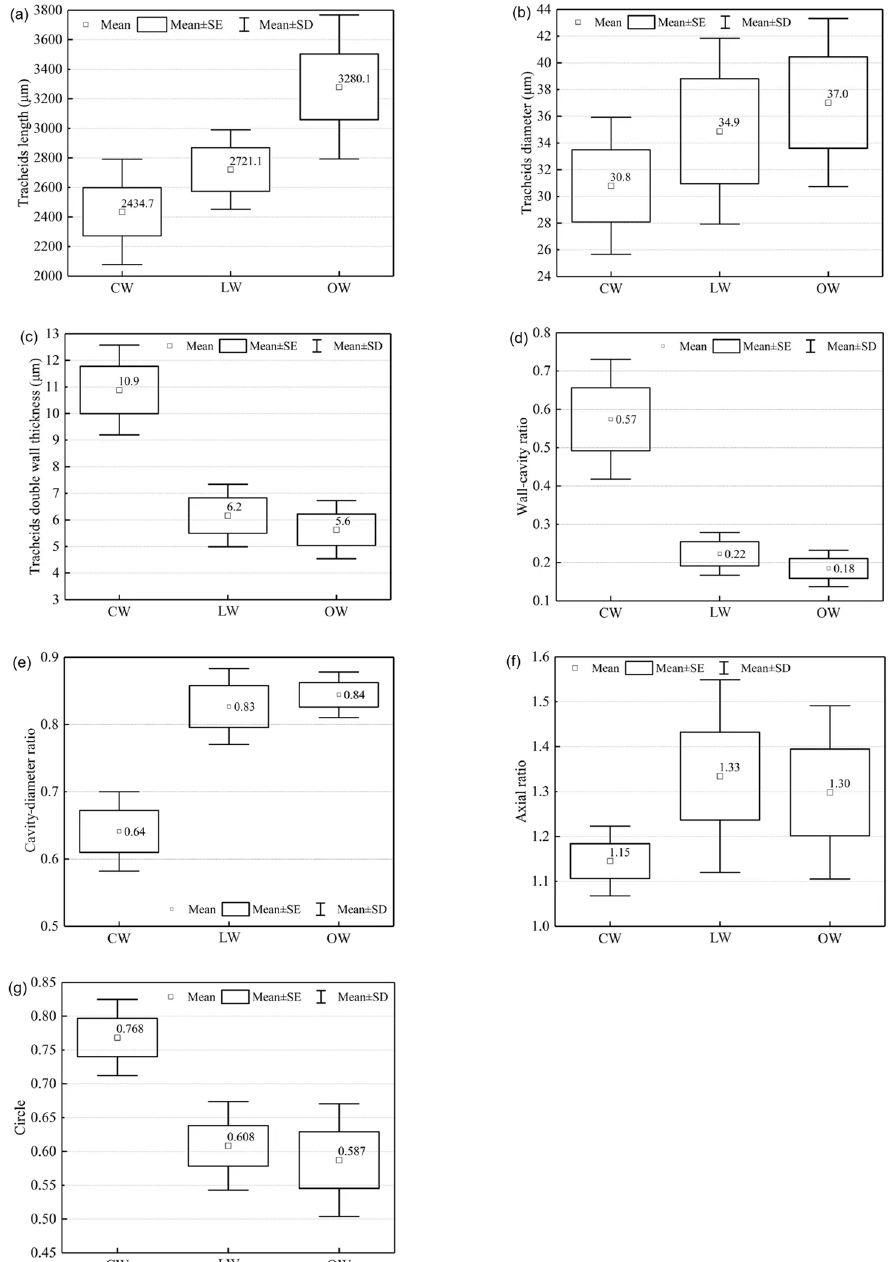
Figure 6. Box and whisker plot of tracheid dimensions for CW, OW, and LW tracheids showing the mean, standard deviation, and standard error. ( a ): tracheid’s length; ( b ): tracheid’s diameter; ( c ): tracheid’s double wall thickness; ( d ): wall–cavity ratio; ( e ): cavity–diameter ratio; ( f ): axial ratio; ( g ): circle.